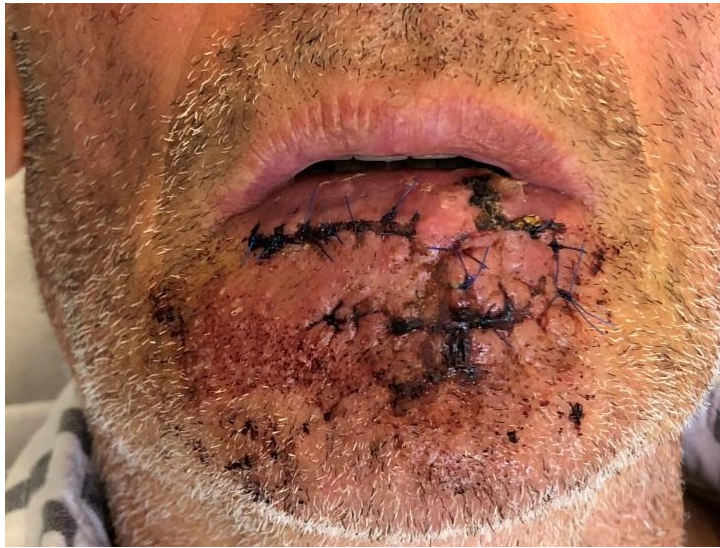
Figure 1. Case 1: Defect involving more than 1/3 of lower lip and the paramedian site.